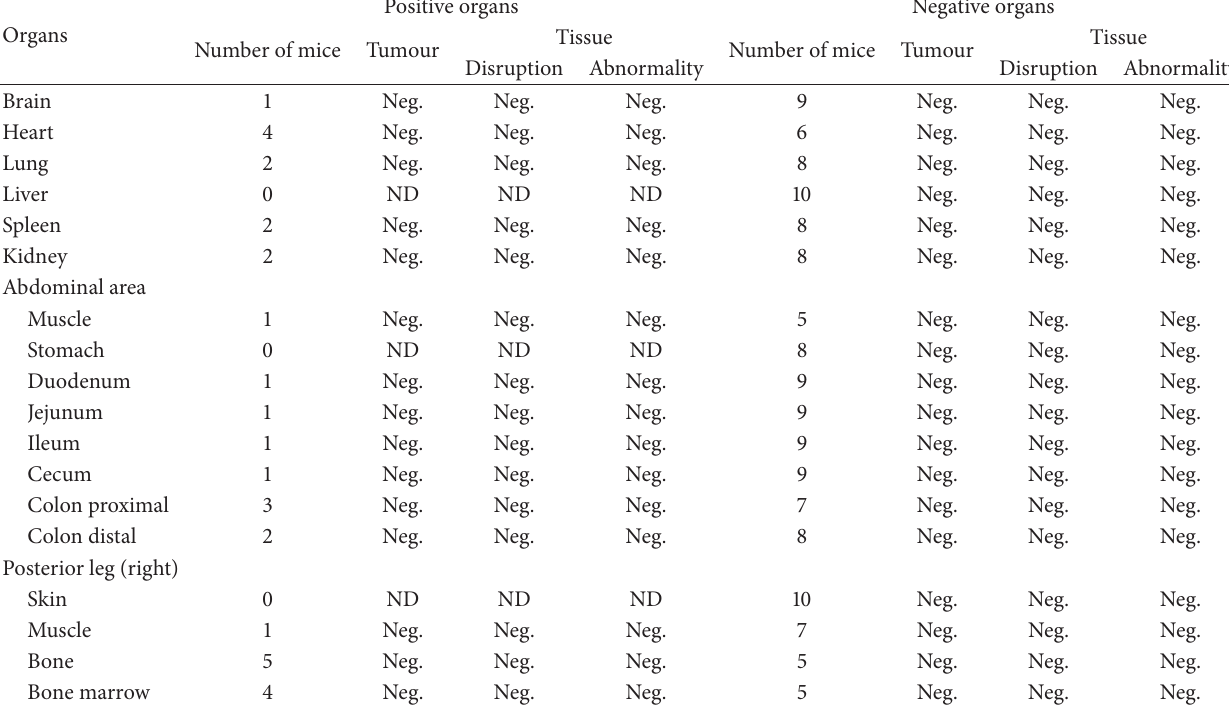
Figure 2: Kinetics of implantation of hMSCs during 120 days after total body irradiation. The percentage of positive mice for the human 𝛽 -globin gene detected by PCR has been calculated after a sublethal total body irradiation (TBI). The human gene has been detected in (a) brain, (b) heart, (c) liver, (d) skin, (e) quadriceps, and (f) bone marrow. The tissues were collected at 3, 7, 15, 30, 60, and 120 days after TBI. The percentages represent the ratio (number of positive mice for the human beta-globin presence divided by total number of animals tested). At each analysis time, each group consisted of 10 animals. The control (named sham) consists in nonirradiated mice injected with hMSCs. The dotted line represents the median of the positive animal percentage during the 60 days after radiation exposure. (g) Illustration of anatomical variations in the presence of MSC after sublethal TBI.